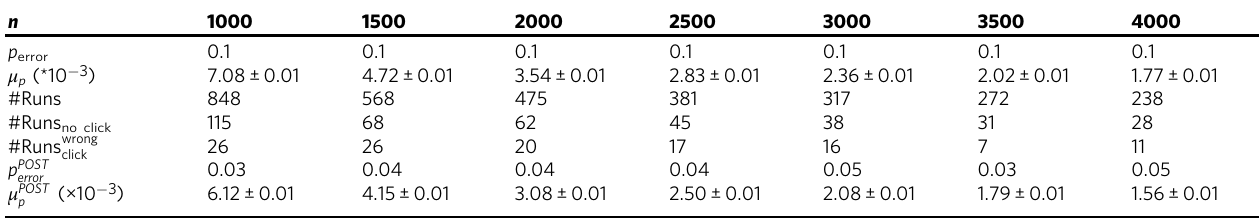
Table 2 Experimental parameters and